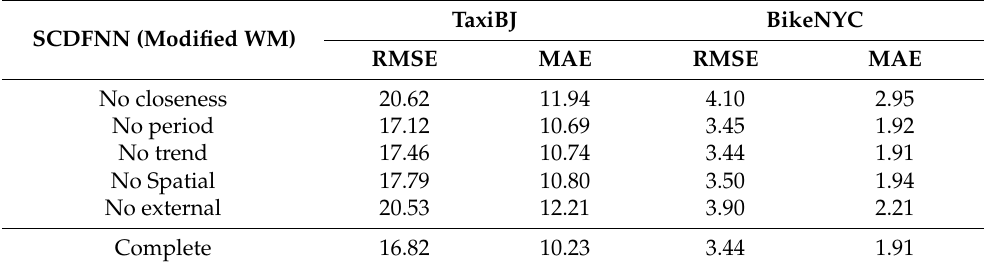
Table 6. Ablation experiment results.